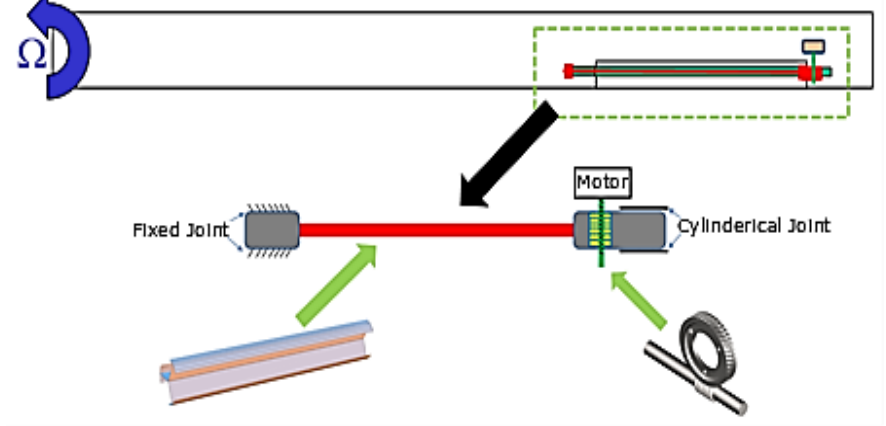
Figure 5. Schematic diagram of application to flexible trailing edge flap system on rotor blade